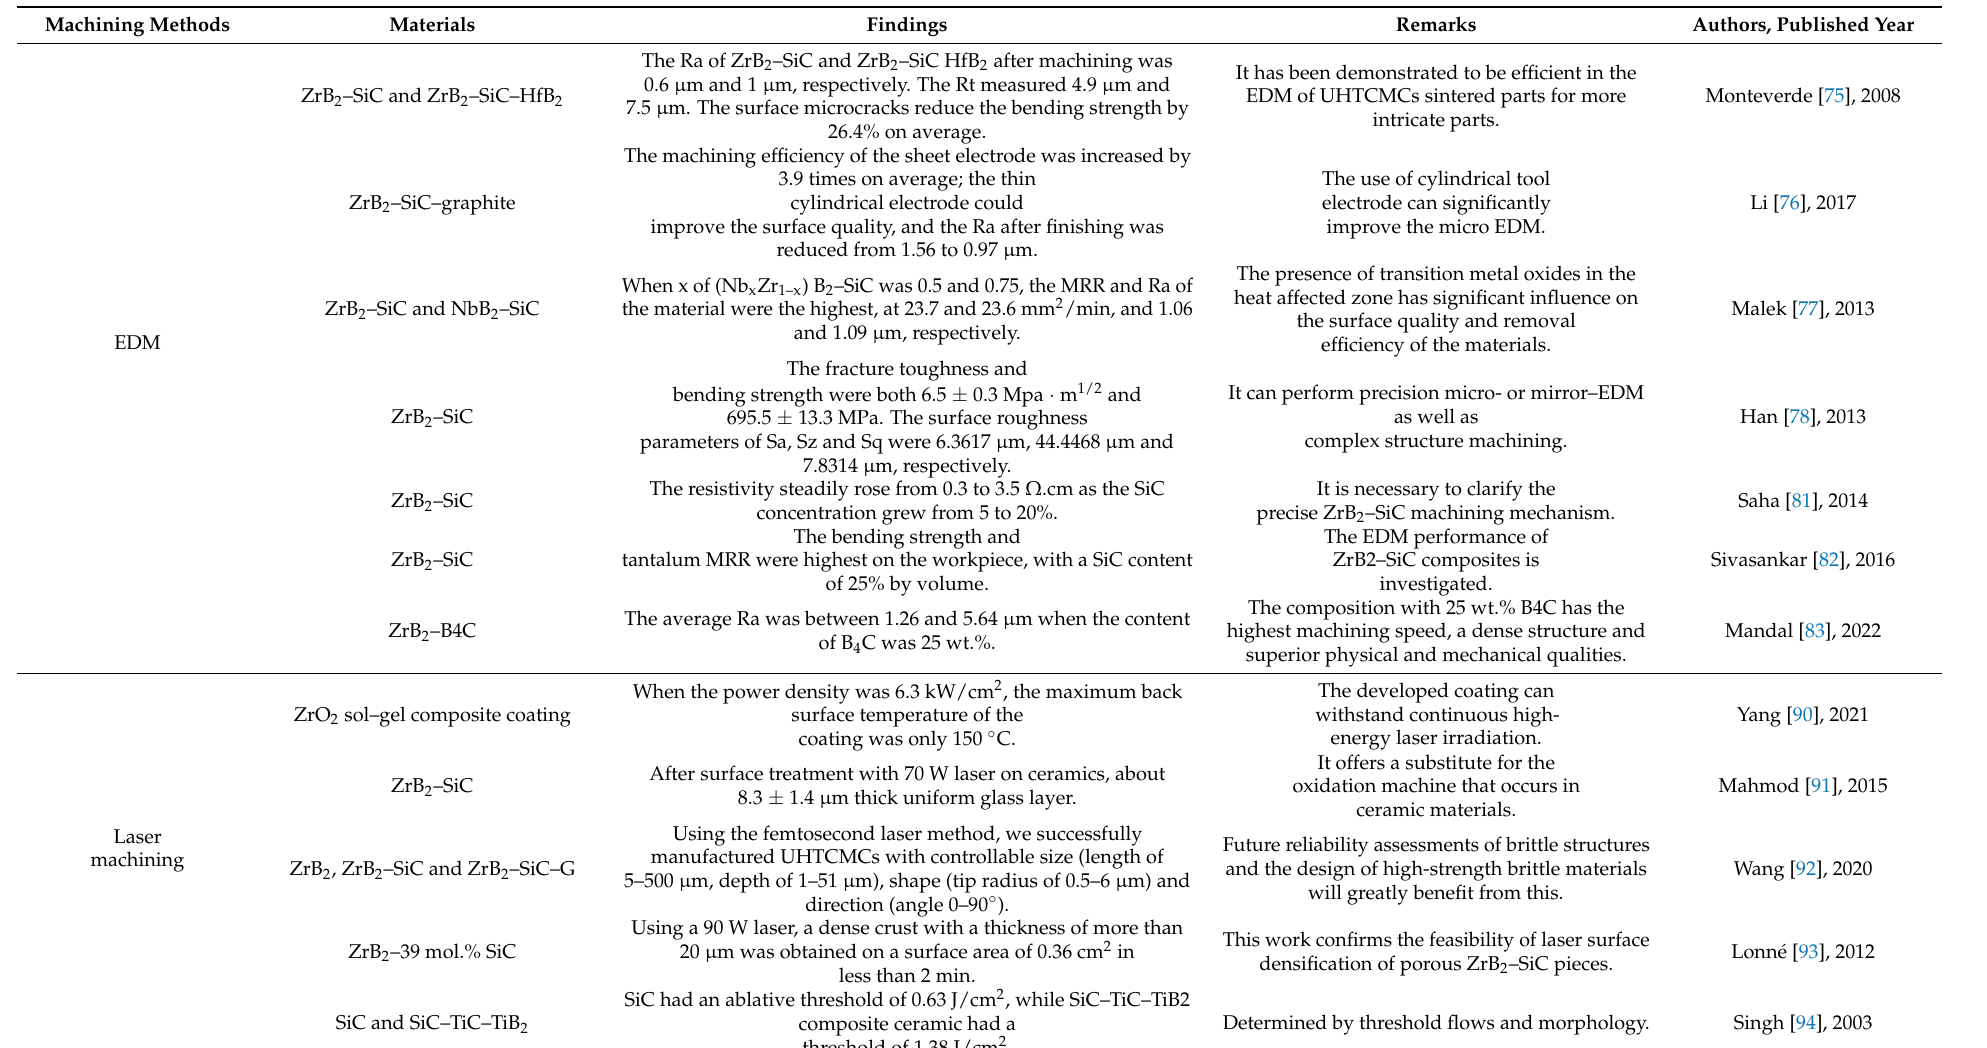
Table 1. Summary of nontraditional machining of boride-based